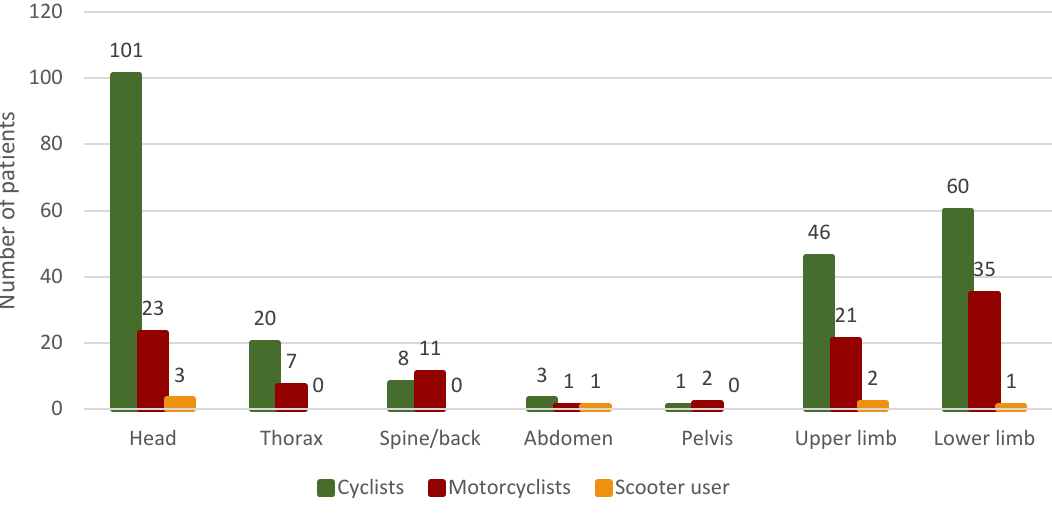
Figure 3. Patients’ injuries, taking into account types of vehicles.